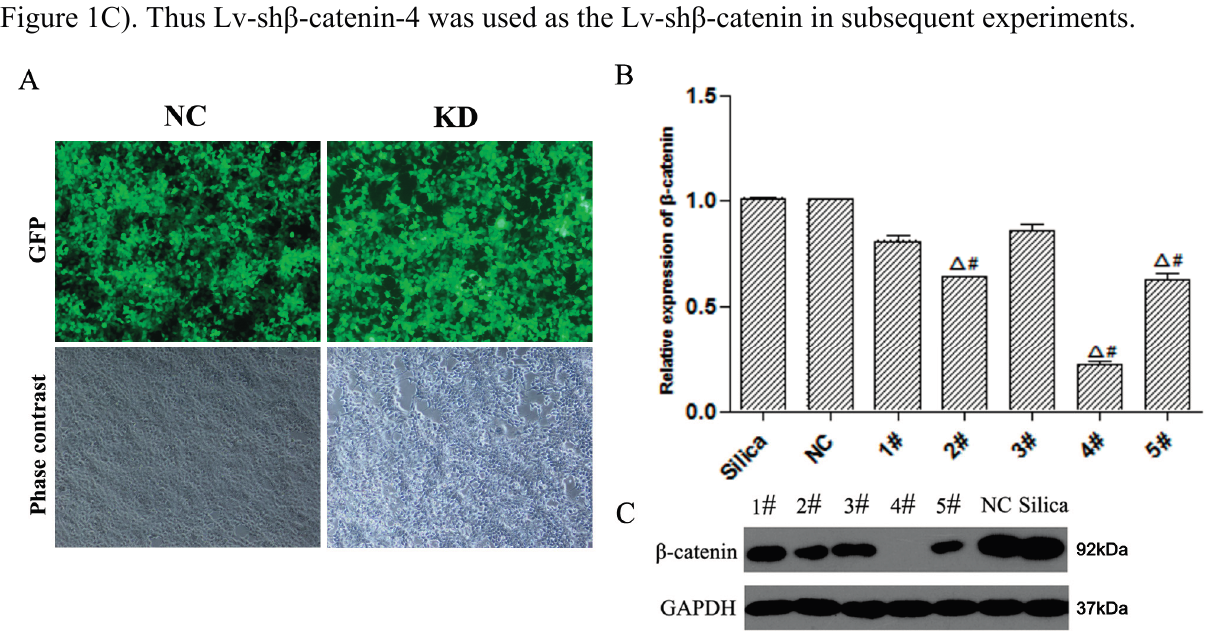
Figure 1 ． Infection of MLE-12 cells with non-silenced control (NC) or Lv-sh β -catenin (KD). ( A ) Cells were infected with NC or Lv-sh β -catenin. Phase contrast image and GFP expression under a fluorescent microscope was taken after 72 h. ( B ) After MLE-12 cells were treated with Lv-sh β -catenin, mRNA level of β -catenin was detected by realtime-PCR by using - ΔΔ Ct method. Data are mean ± SEM (n = 3). ( C ) Protein level of β -catenin was detected by western blot. Cells of each group were incubated with silica. Lanes 1–5: Lv-sh β -catenin-1, -2, -3, -4, -5, respectively. Δ p < 0.05, compared to the silica group; # p < 0.05, compared to the NC